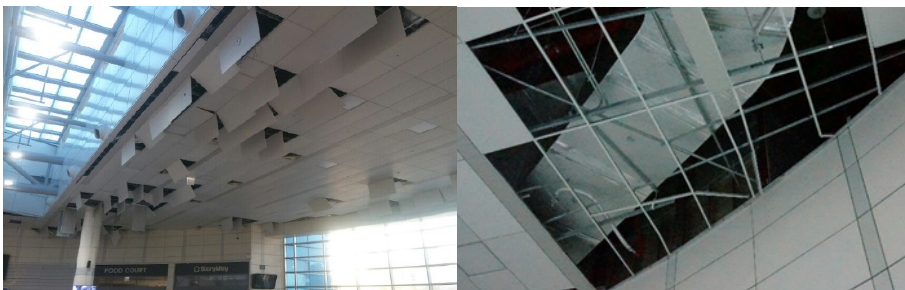
Figure 1. Damage case of ceiling system due to Pohang earthquake in Pohang Station.